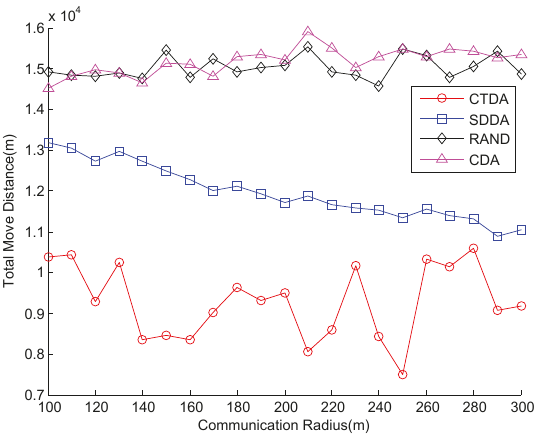
Figure 11. Comparison of distances moved with varying communication radii under a sparse